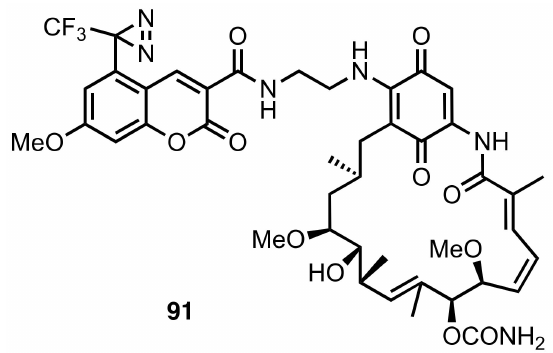
Figure 1. Diazirinyl coumarin-substituted GA probe